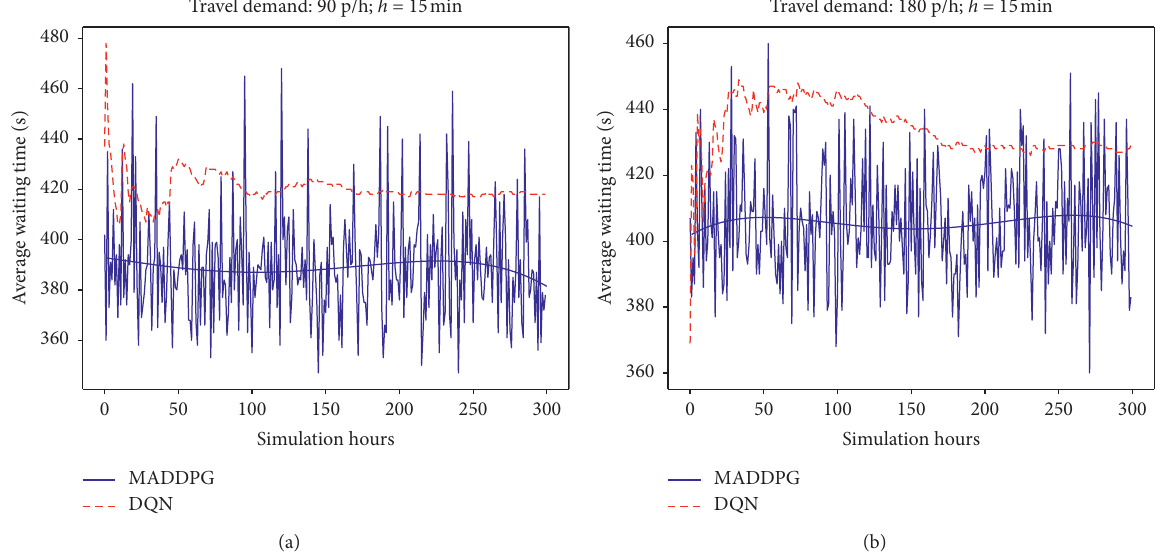
Figure 4: Performance comparison between the MADDPG and DQN algorithms for a travel demand of 90 and 180 passengers/ h in a single- agent